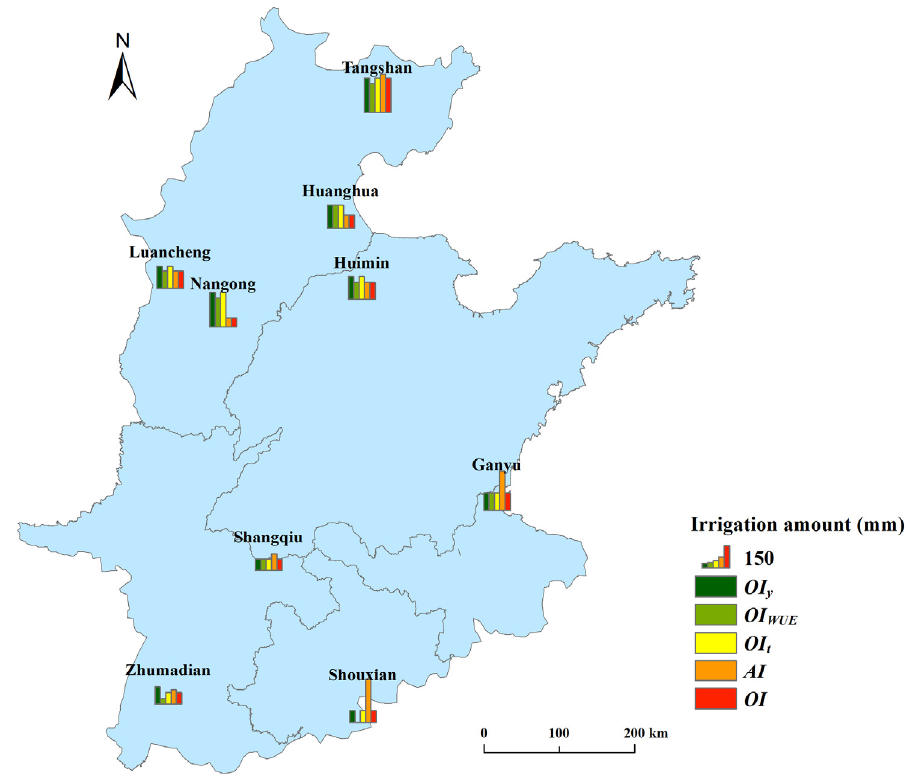
Figure 5. The optimal irrigation amount and the available irrigation amount of winter wheat in the North China Plain. Notes: OI y is the optimal irrigation amount for a high yield of winter wheat; OI WUE is the optimal irrigation amount for water saving of winter wheat; OI t is the optimal irrigation amount for the trade-off between high yield and water saving; AI is the available irrigation amount; OI is the final optimal irrigation amount constrained by the available irrigation amount.